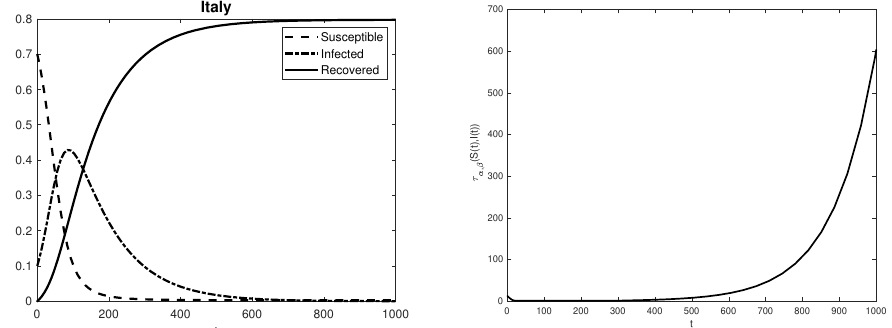
Figure 5. Solution to the SIR model (1), with initial value given by the vector (4), for Italy ( left ) and corresponding pattern of τ α , β ( S ( t ) , I ( t )) ( right ).